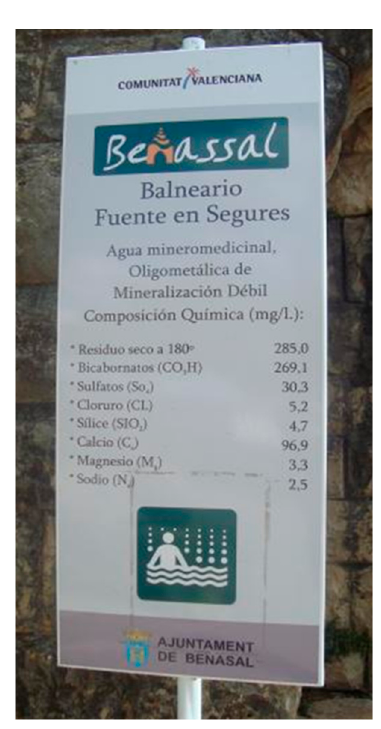
Figure 4. Benasal: Spanish-only sign on a spa .